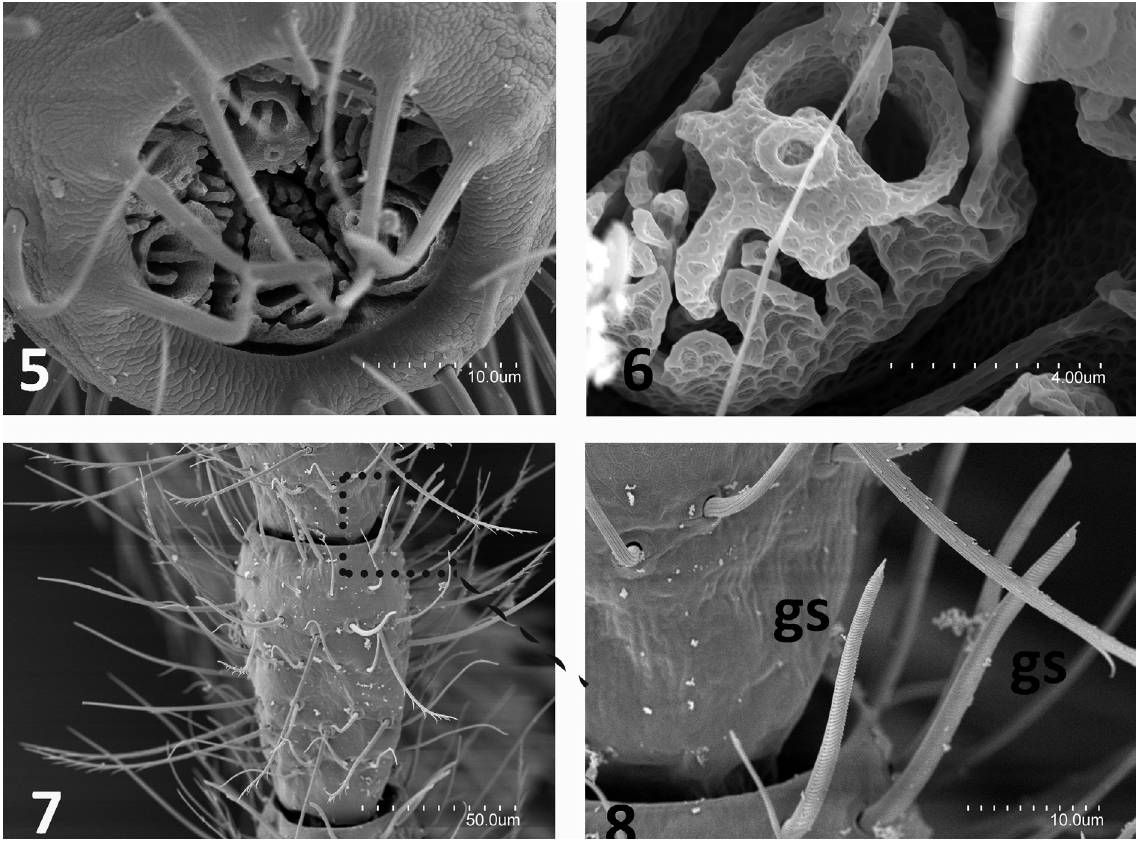
Figs 5‒8. Anisuracampa ywangana Sendra & Komerički sp. nov. 5 . Apical view of last antennomere. 6 . Olfactory chemoreceptor of the cupuliform organ. 7 . Central antennemeres. 8 . Lateral distal medial antenomere with gouge sensilla (gs).